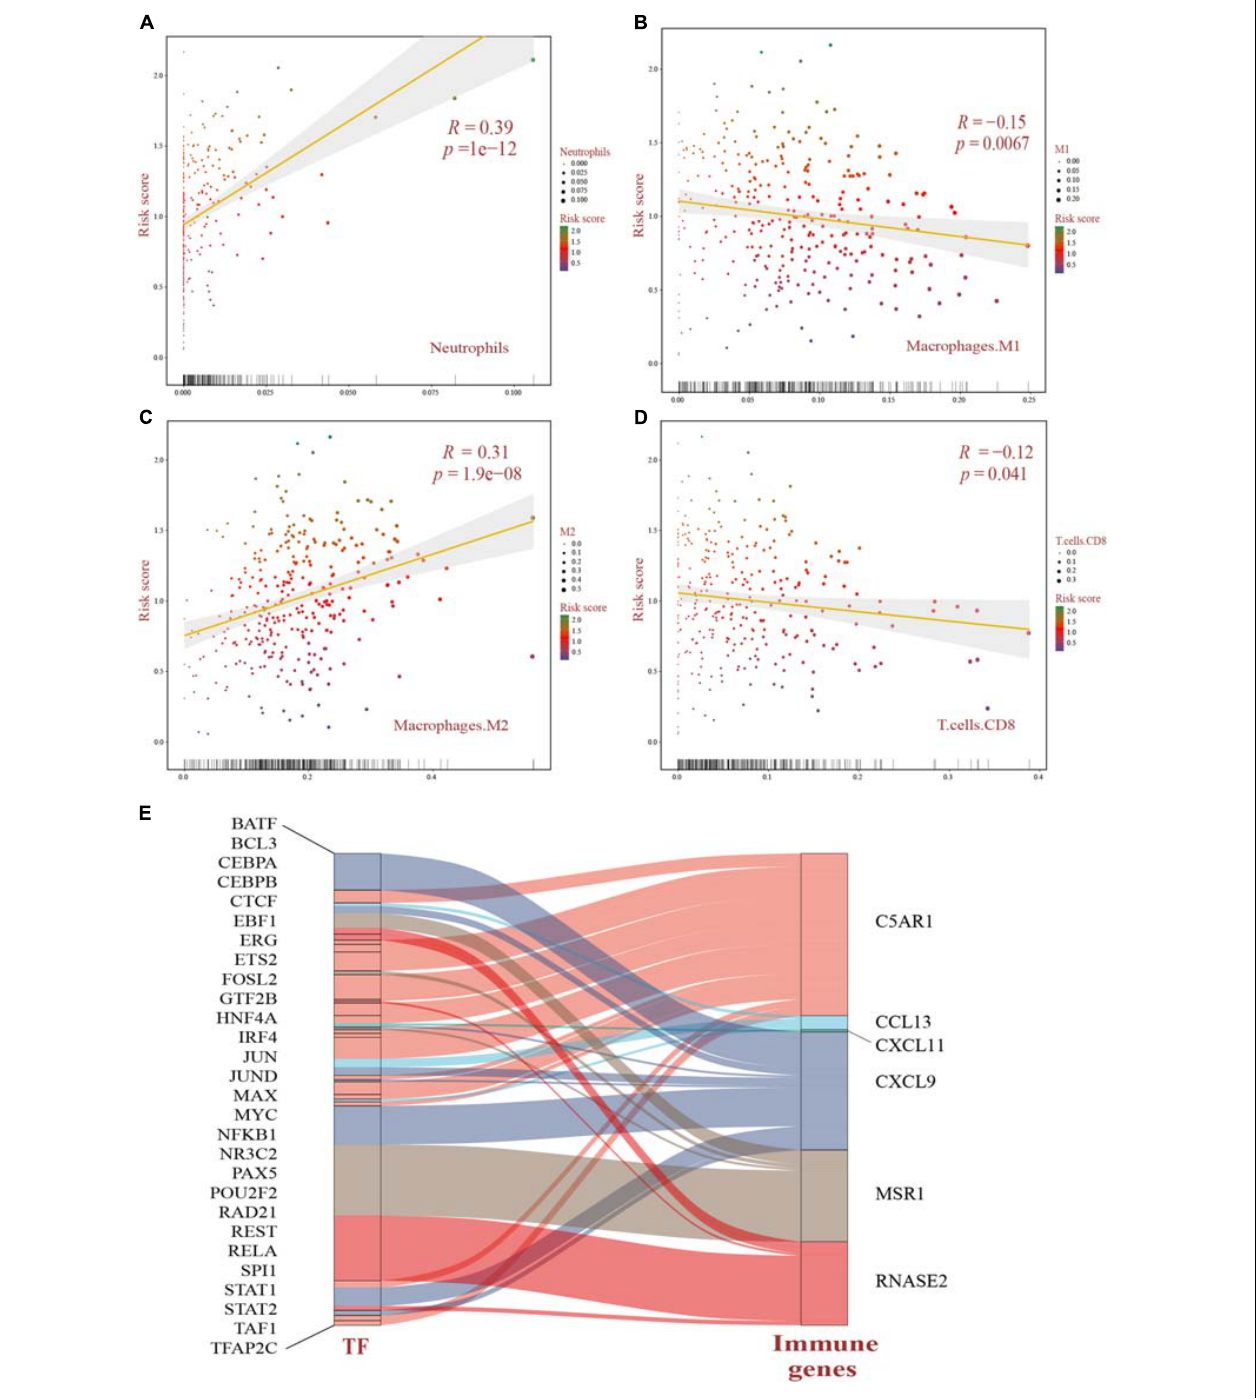
FIGURE 8 | (A–D) Pearson’s correlation analysis of the risk score distribution and immune cell infiltration significantly identified by CIBERSORT in OV patients. All p values were corrected by the BH method. (E) Upstream regulatory mechanisms revealed the network among TFs and immune genes using the Sankey plot. The width of each alluvial stripe in the TF column represents -log2 ( p values) of pairwise Pearson’s correlation adjusted. TFs, transcription